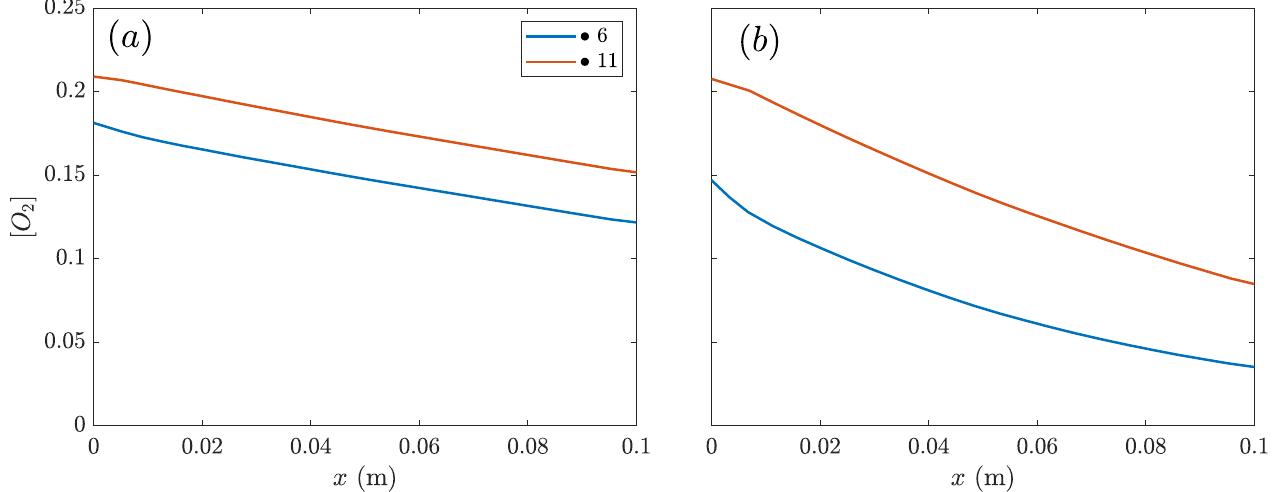
Figure 9. Oxygen mass fraction in cathode along the x -coordinate at low voltage (0.45 V): ( a ) SIGRACET 34BC (MPL), ( b ) SIGRACET 34BC without MPL.